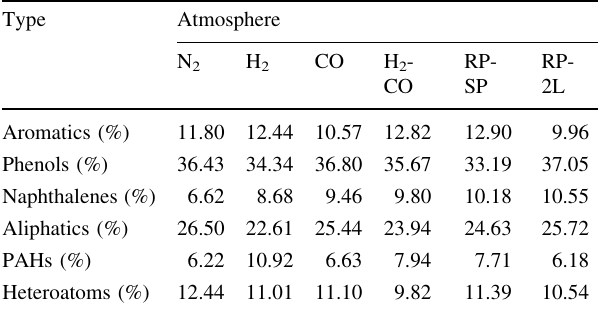
Table 2 Products distribution in coal tar collected under different atmosphere